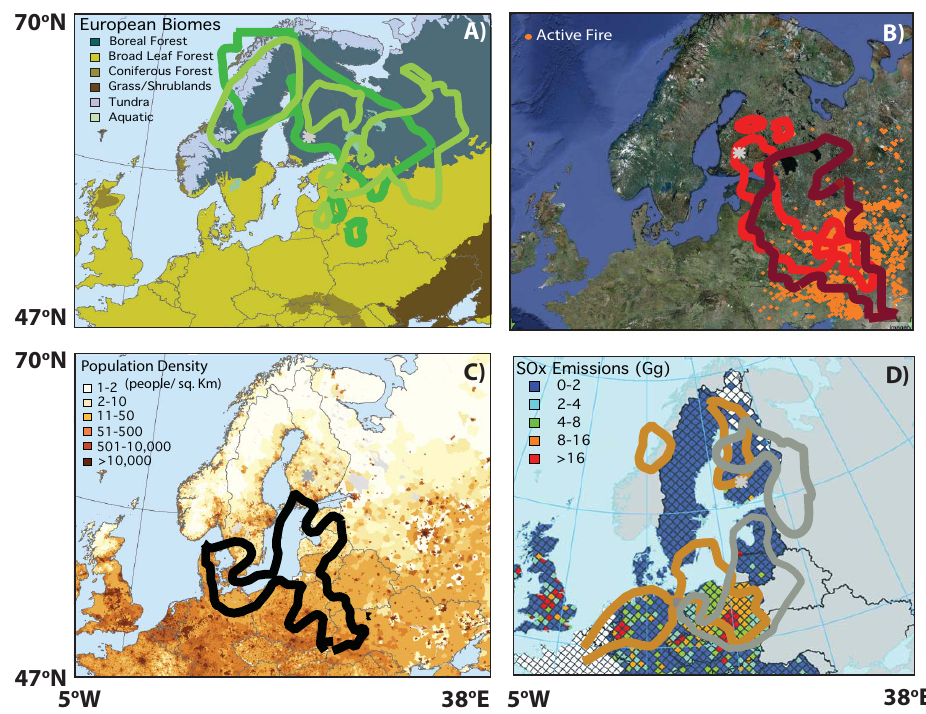
Fig. 5. PSCF of AMS and FTIR factor fractions with contours indicating 0.4 probability of potential source region in each map. (A) BIO FTIR (green) and OOA-1a AMS (light green) contours showing proximity to regional vegetative biomes (map: PLACE III – Europe Biomes, http://sedac.ciesin.columbia.edu/data/set/nagdc-population-landscape-climate-estimates-v3). (B) BB FTIR (red) and OOA-1b AMS (dark red) contours and active wildfire hotspots (12 July–12 August 2010) in eastern Europe and Russia, for fires with >90% confi- dence (fire data: NASA FIRMS, 2012. MODIS active fire detections. Available online https://earthdata.nasa.gov/FIRMS). (C) FFC1 FTIR (black) contours and population density for Europe and western Russia (map: PLACE III – Population Density 2010, Europe, http: //sedac.ciesin.columbia.edu/data/set/nagdc-population-landscape-climate-estimates-v3). (D) FFC2 FTIR (brown) and OOA-2 AMS (grey) contours with 2005 SO x emissions (no-SO x data are shown in white, and grey regions indicate outside of the study area) (map: EEA, www.eea.europa.eu/data-and-maps/figures/emissions-of-sox-in-2005). Hyytiälä is denoted by a grey asterisk in each